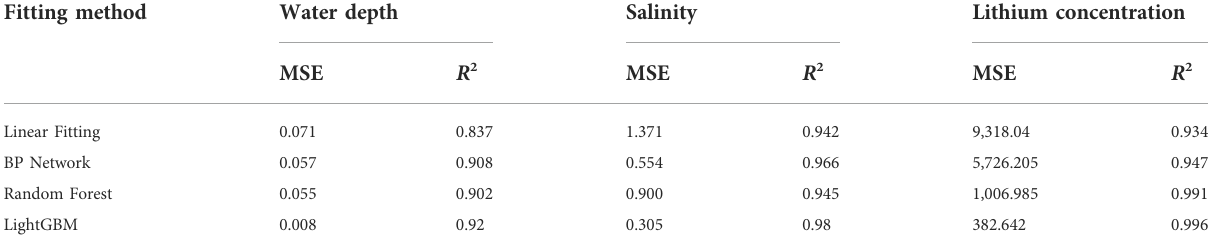
TABLE 4 Fitting results for different